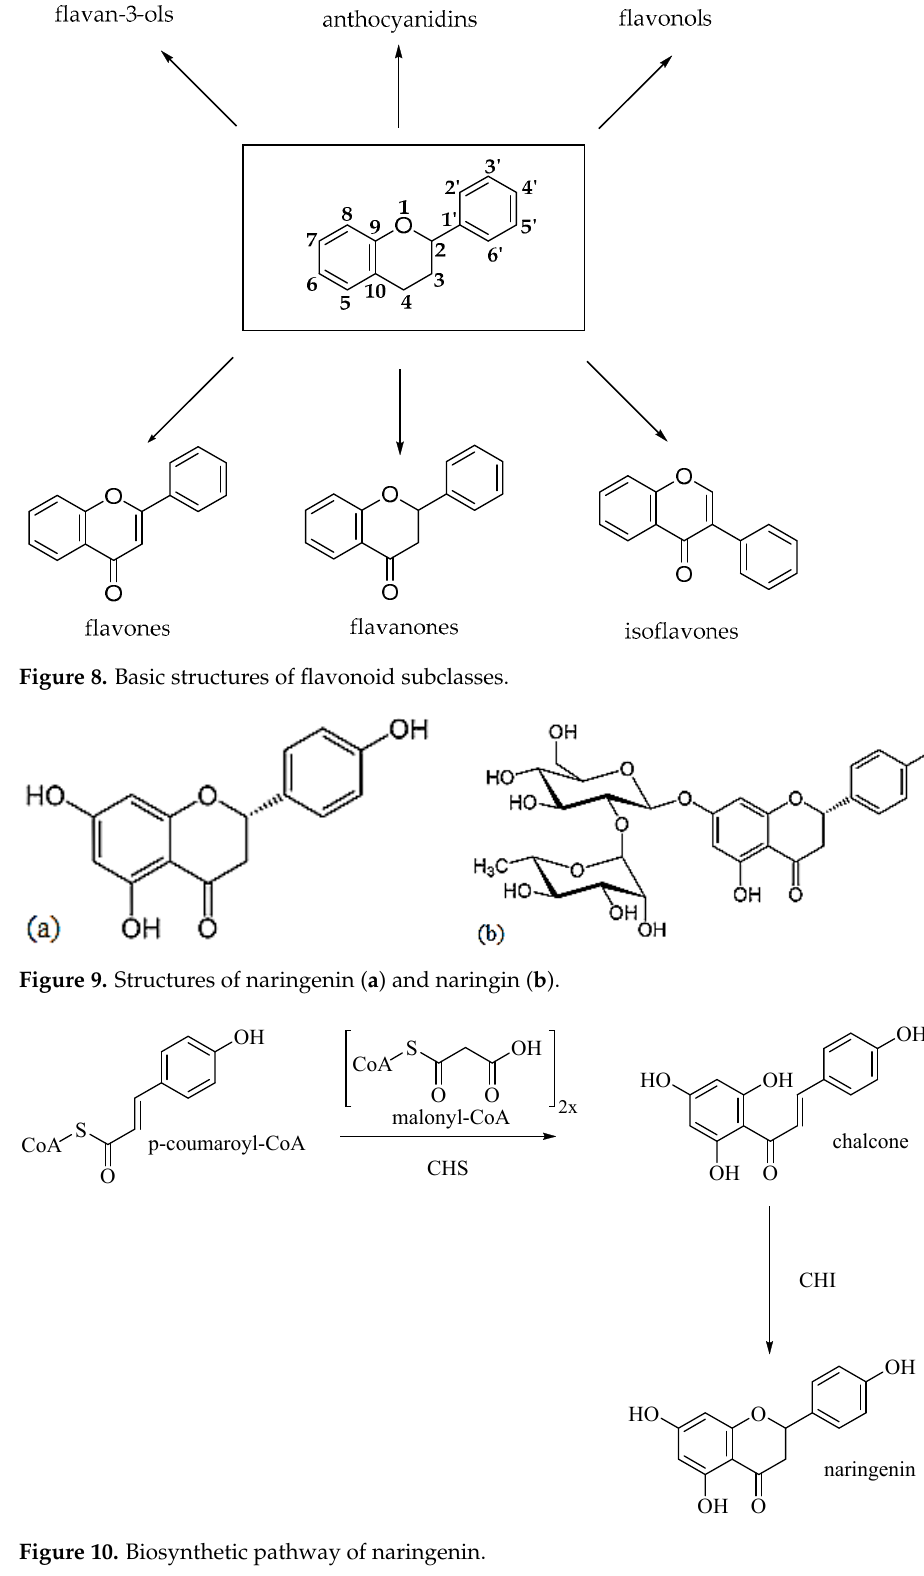
Figure 8. Basic structures of flavonoid subclasses .